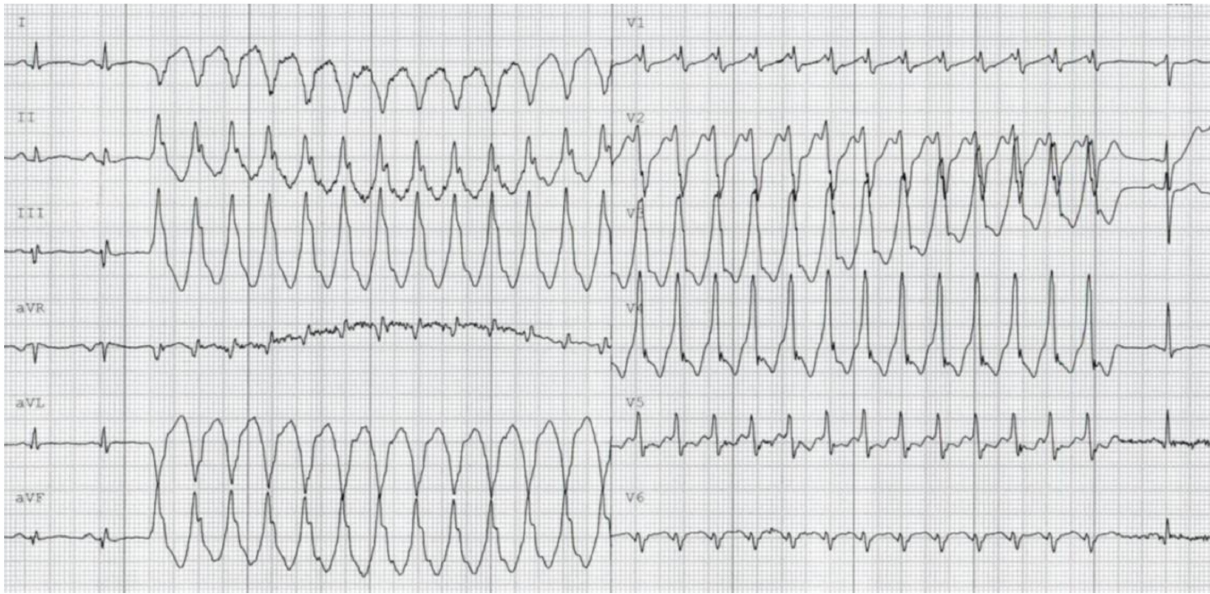
Figure 4. ECG showing a non-sustained VT during monitoring at the cardiac care unit